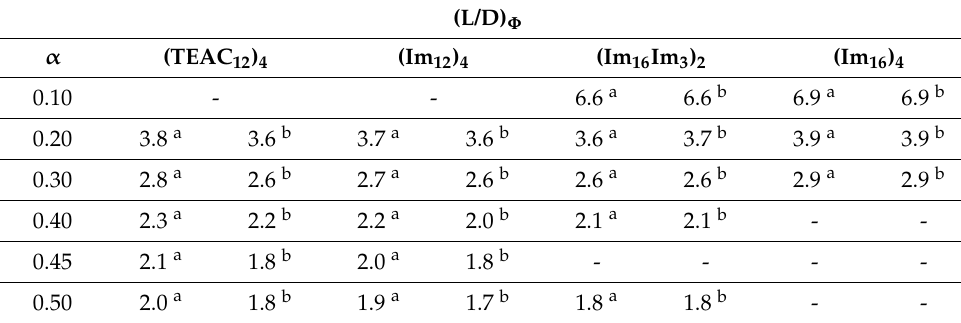
Table 2. Theoretical and experimental (L/D) Φ